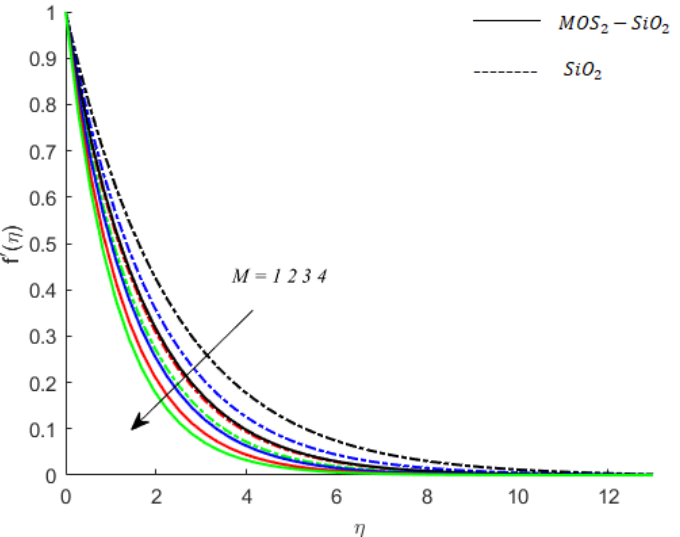
Figure 2. Influence of M on velocity when Pr = 0.9, Ec = 0.2, Sc = 0.8, K = 0.1, Bi = 0.05, β ∗ = 0.1, γ = 0.1, γ 1 = 0.1 .